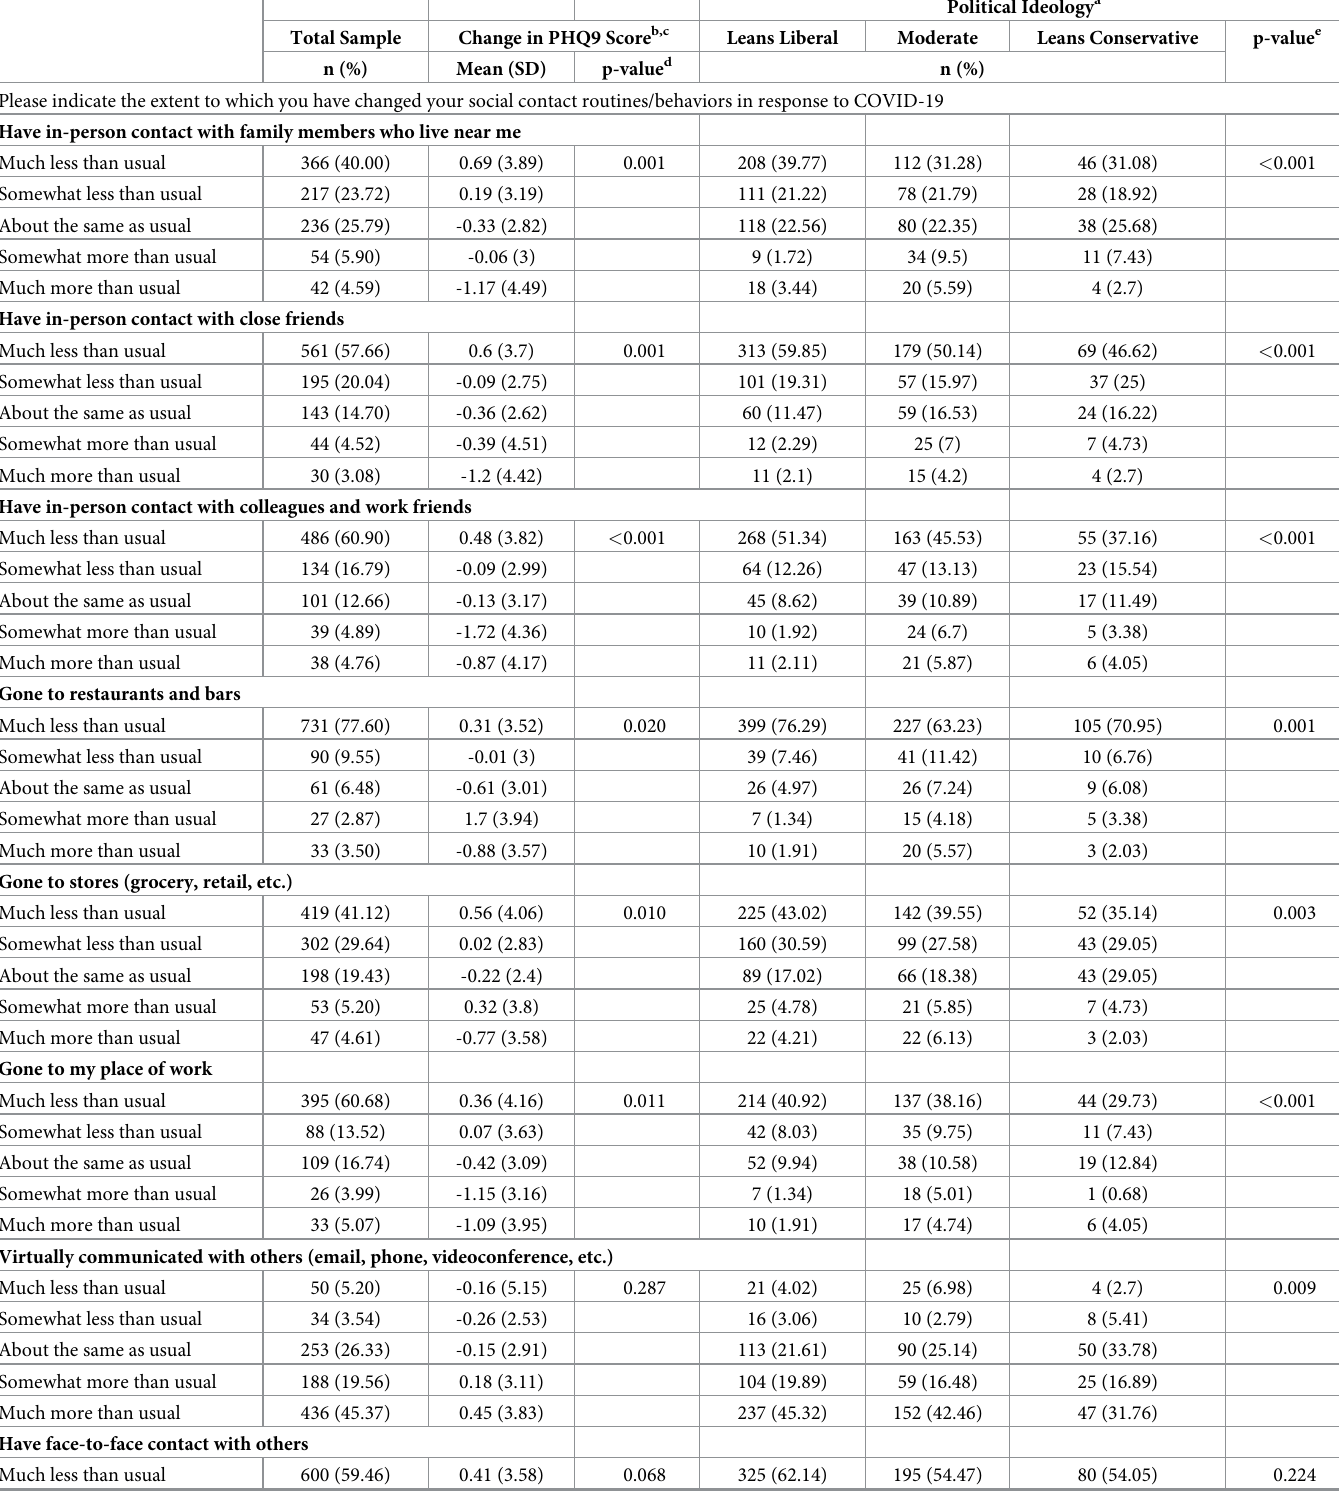
Table 4. Influence of political ideology on behavior changes and the impact on behavior changes on mental health. Political Ideology a Total Sample Change in PHQ9 Score b,c Leans Liberal Moderate Leans Conservative p-value e n (%) Mean (SD) p-value d n